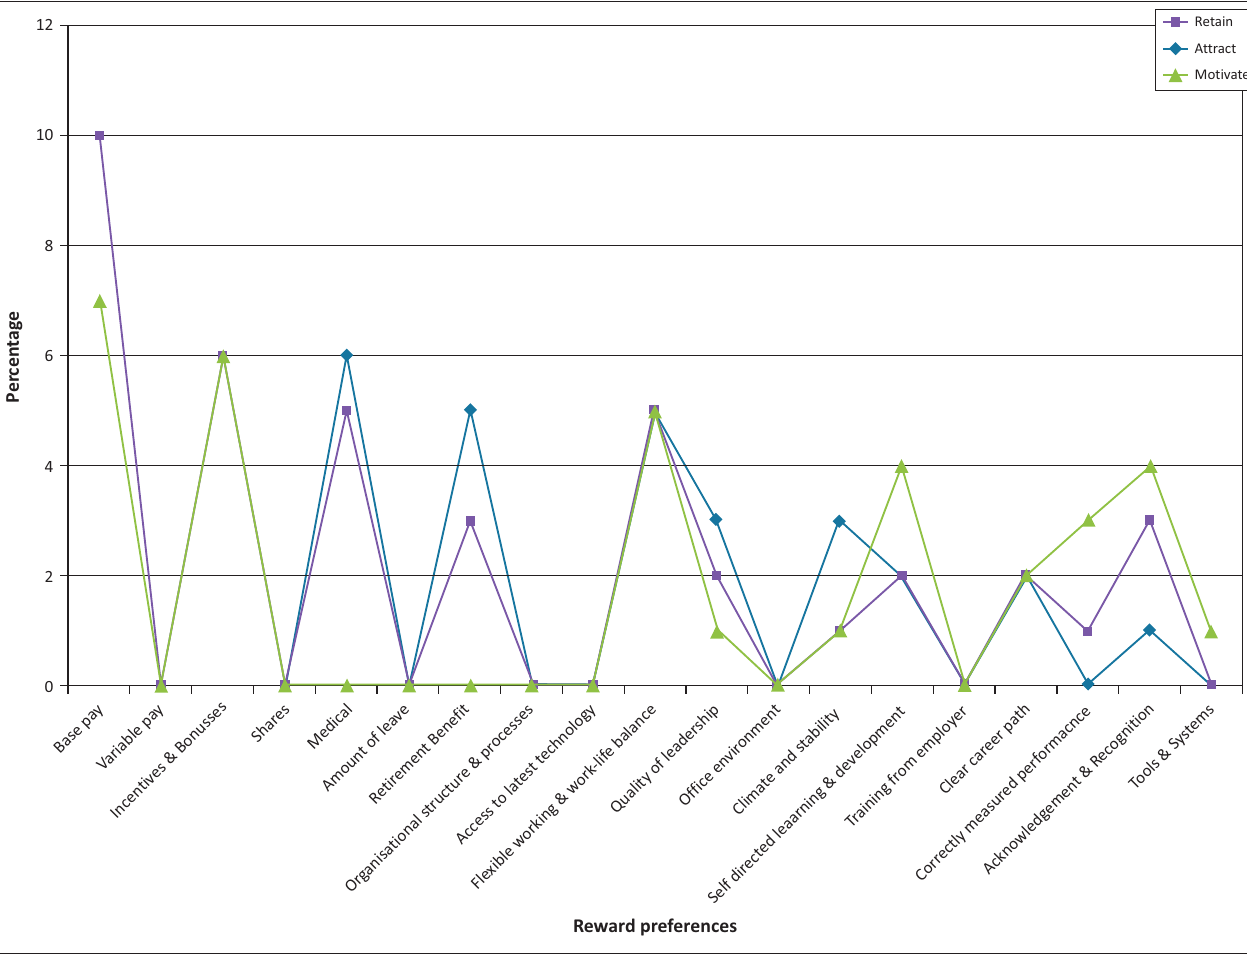
FIGURE 2: Different reward preferences for attract, retain and motivate. TABLE 9: Summary of Friedman ANOVA results of statistical significance in reward preferences for attract, retain and motivate. Reward